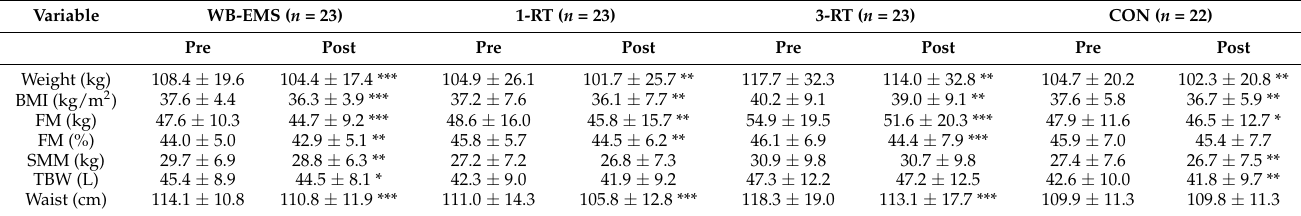
Figure 2. Changes in body weight ( A ), waist circumference ( B ), fat mass ( C ), and skeletal muscle mass ( D ). * ( p < 0.05), ** ( p < 0.01), *** ( p < 0.001): significantly different from pre-intervention.; ++ ( p < 0.01): significant difference vs. CON. Table 3. Anthropometric and body composition data pre and